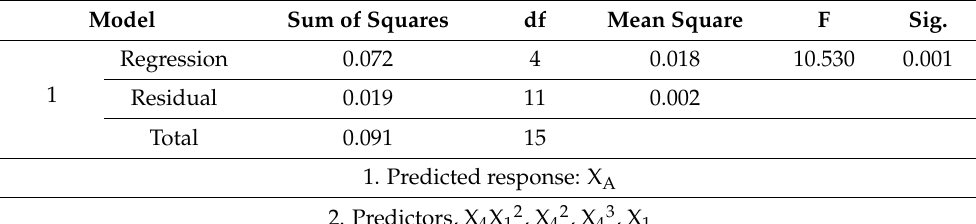
Table 20. ANOVA for 3rd order polynomial with two